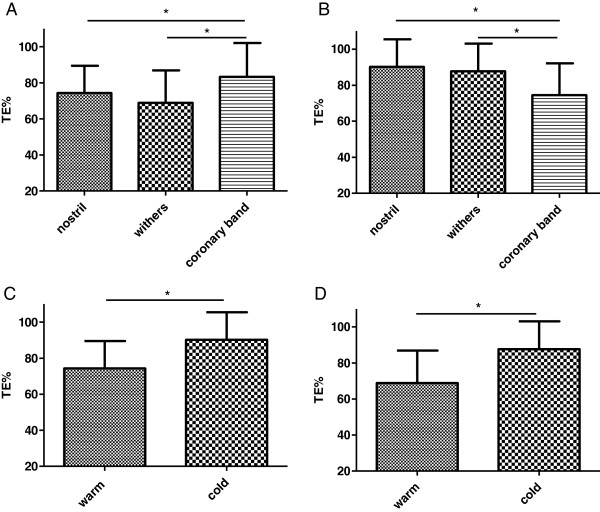
Influence of ambient temperature and different stimulation conditions on percentage thermal excursion. All diagrams show percentage thermal excursion (TE % = 100 × ([TT – T0]/[Tc-T0]), TT is the thermal threshold temperature, T0 is the skin temperature and Tc is the thermal cut-out temperature (Brosnan et al. 2009)). These results were formed without differentiating of place or day time. A: TE % at three different body parts (nostril, withers, coronary band). Thermal stimulation was performed during warm ambient temperature. B: TE % at three different body parts (nostril, withers, coronary band). Thermal stimulation was performed during cold ambient temperature. Data of 13 measurements at the coronary band had to be excluded because neither end-point nor cut-out temperature could be reached. C: TE % was compared between warm and cold ambient temperatures during measurements at the nostril. D: TE % was compared between warm and cold ambient temperatures during measurements at the withers.